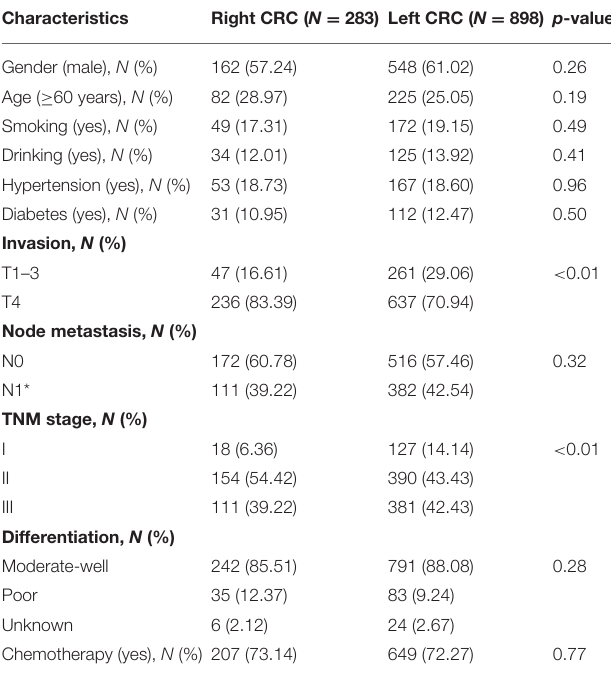
TABLE 1 | The baseline characteristics of 1,181 stage I–III surgical colorectal cancer patients in the study.